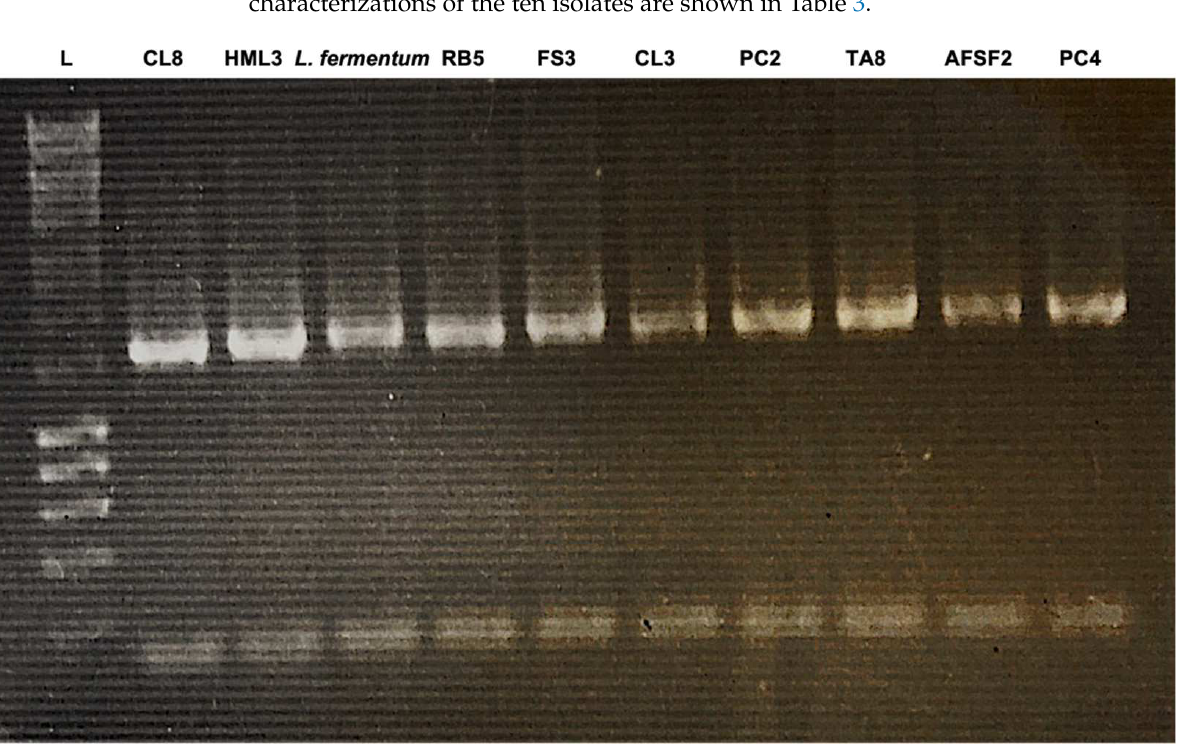
Figure 1. The amplified DNA from PCR reactions of 0.8% agarose gel ran at 110 V for 60 min using Hyperladder 1 kB as DNA ladder (L), and each sample was loaded at 10 uL, respectively. The first strains from well number 2 (start from left is CL8, HML3, Lactobacillus fermentum RB5, FS3, CL3, PC2, TA8, AFSF2, PC4). Table 3. API 50CHL kit identification of the ten LABs with their characterizations and fermentable sugars.